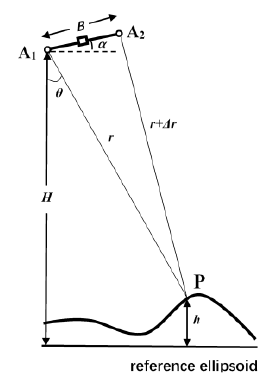
Figure 3. Principles of height measurement using an interferometric imaging altimeter.